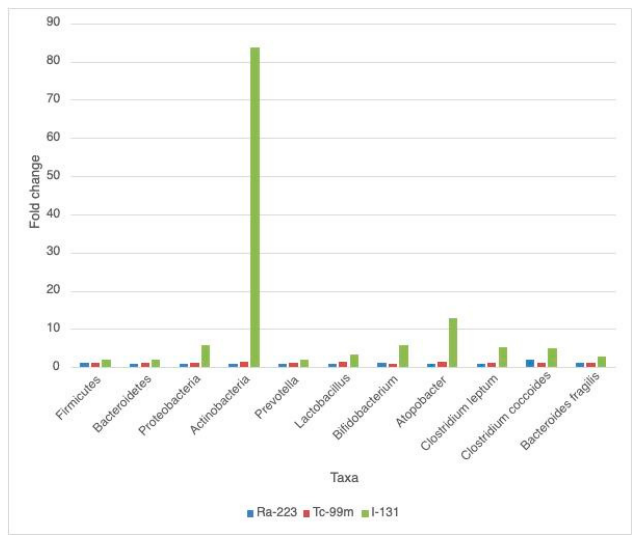
Figure 1. Fold change in each taxa and in each